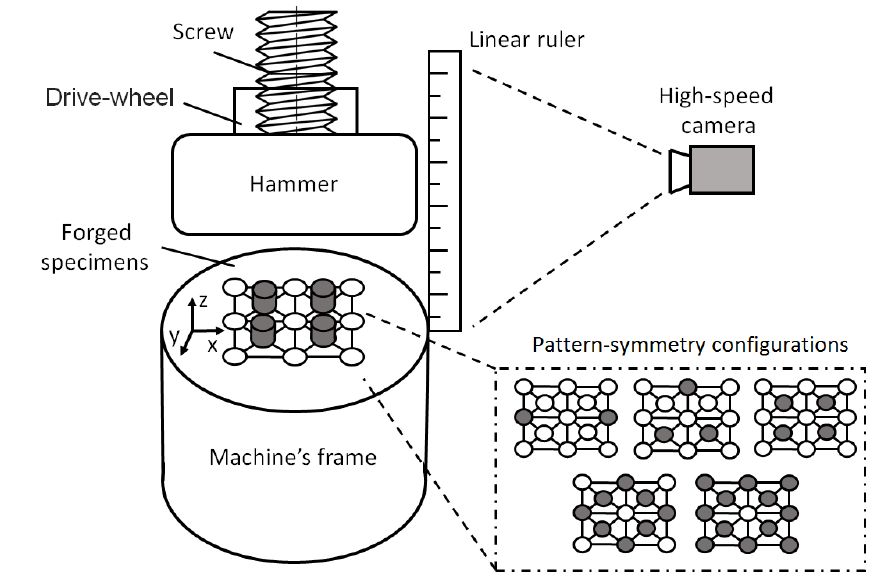
Figure 3. Test configurations for the screw friction press and the pattern symmetry configuration of different specimens